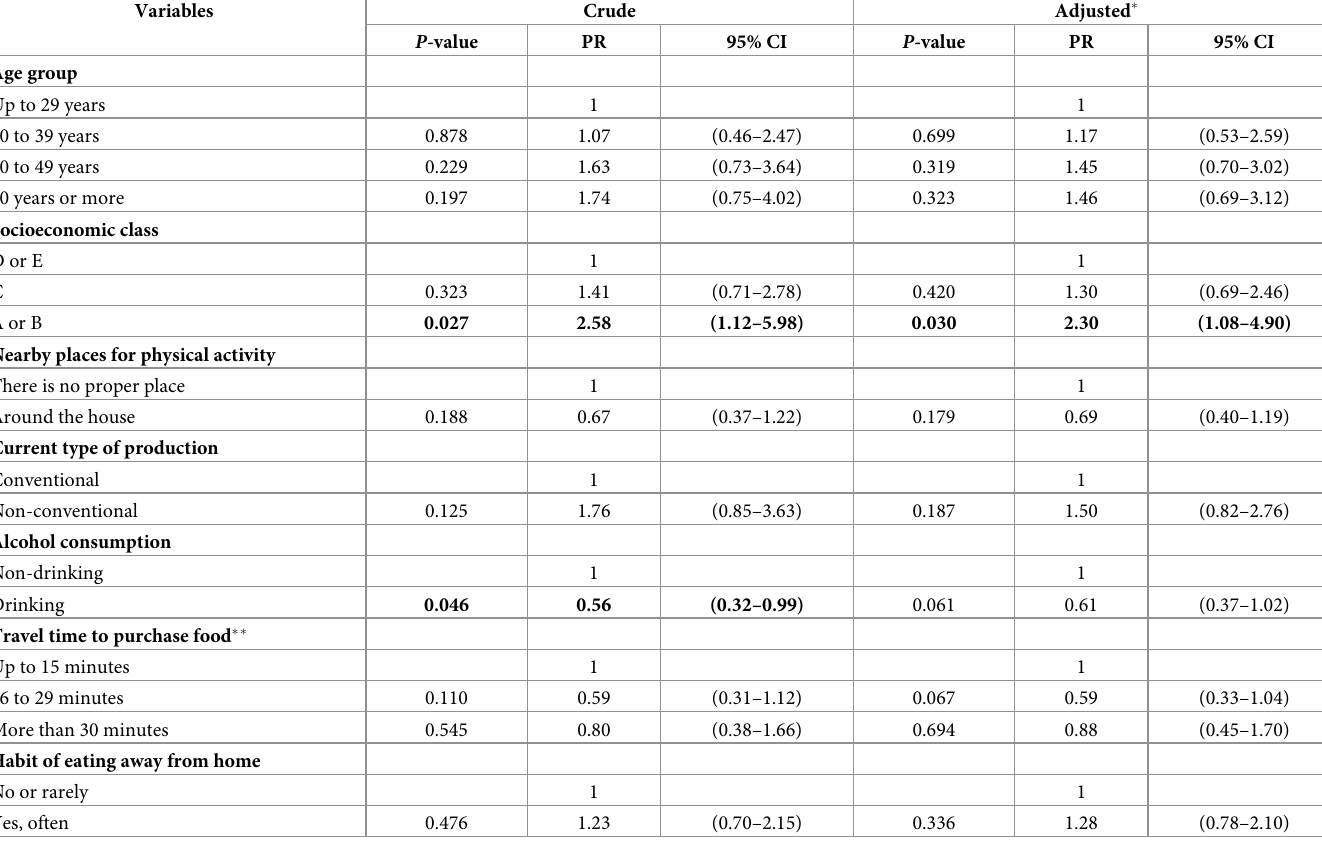
Table 5. Factors associated with general obesity among men in a rural Brazilian